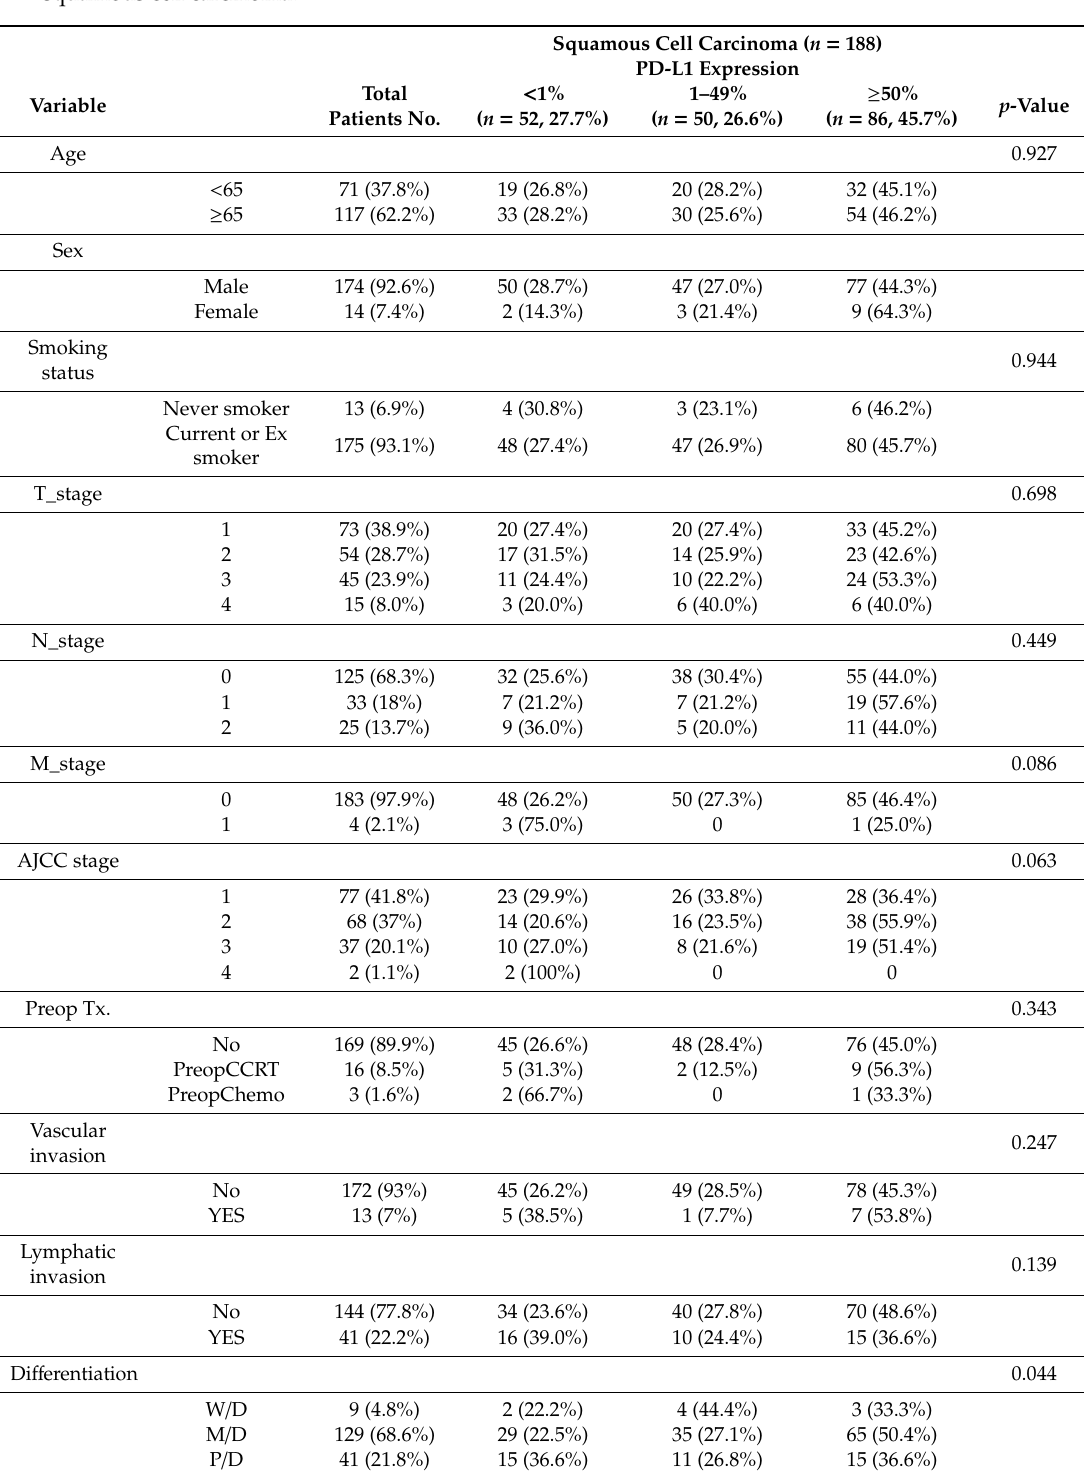
Table 2. Association between PD-L1 expression status and clinicopathological features in 188 lung squamous cell